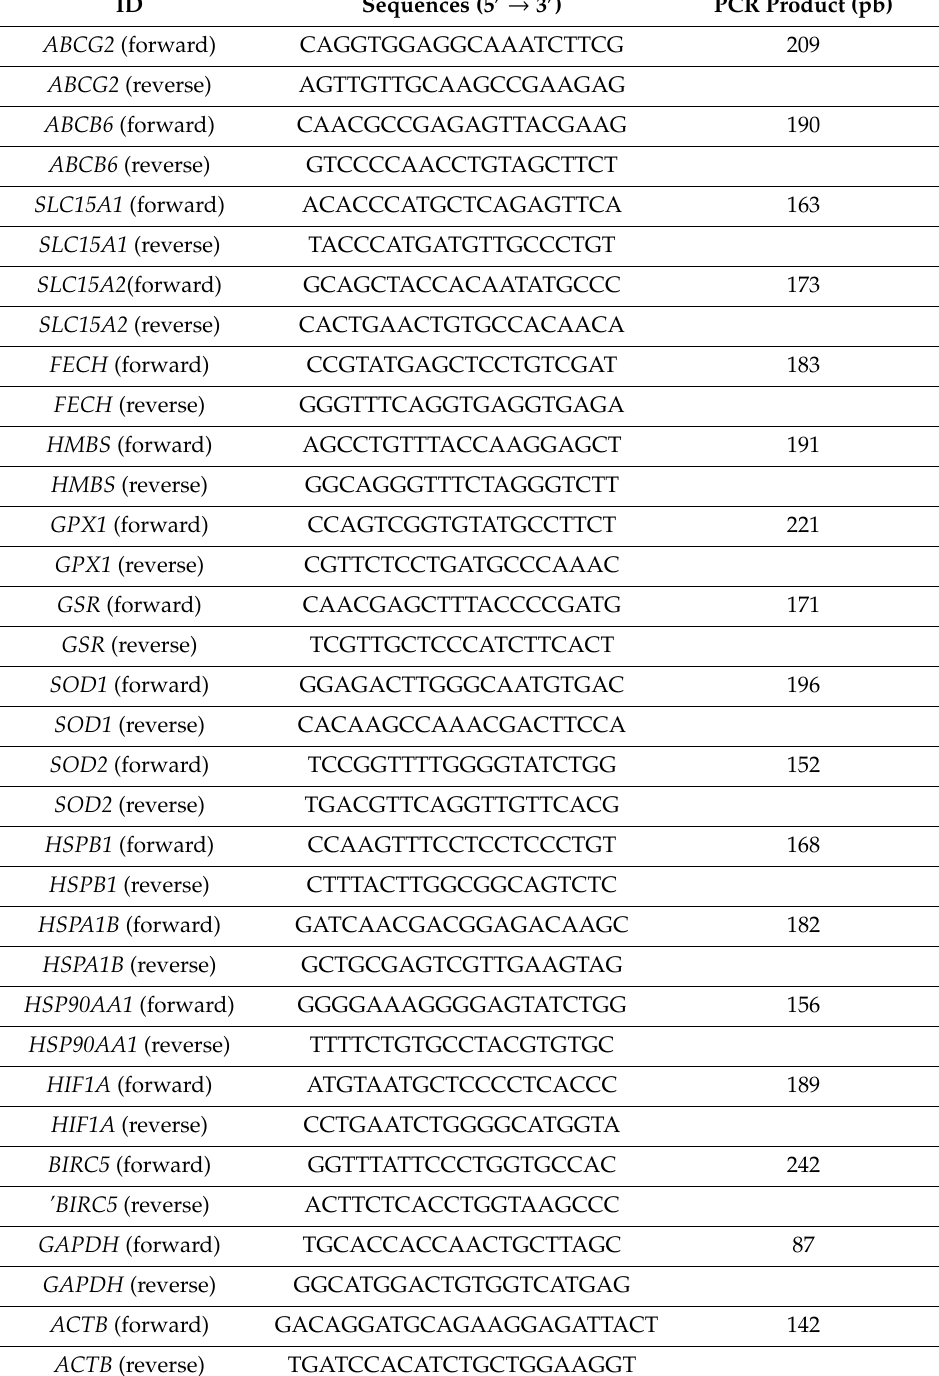
Table 1. Primer sequences used for qPCR